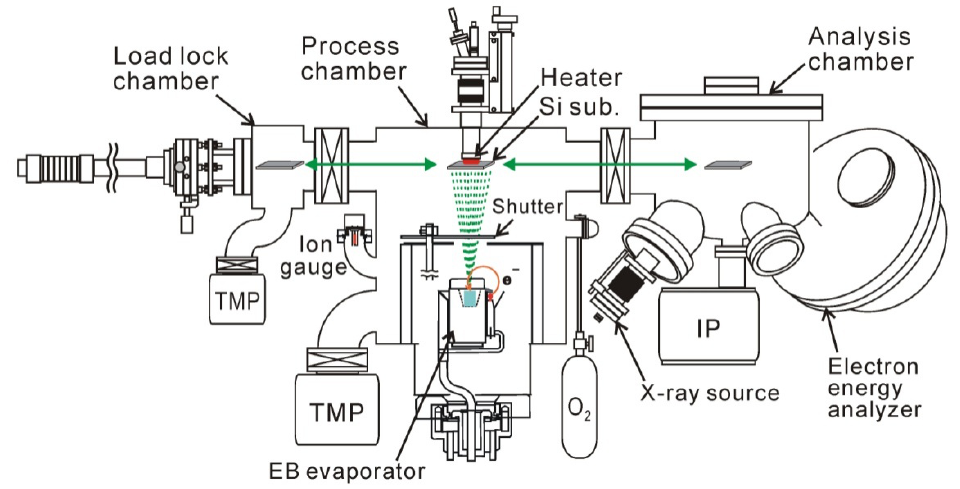
deposition, post-deposition annealing (PDA), Figure 1. Experimental setup used for HfO 2 and surface analysis. XPS system was connected to UHV-EB evaporation chamber for in-vacuum analysis of surface